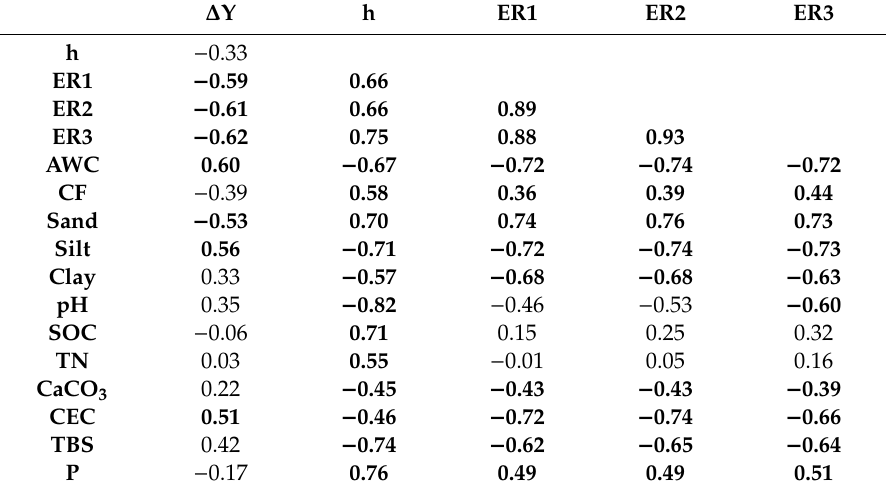
Table 3. Pearson’s correlation between the mean yield variation ( ∆ Y), elevation (h), electrical resistivity (ER1, ER2, ER3) measured by proximal sensing and soil features (CF: coarse fragments, AWC: available water capacity, TN: total nitrogen, SOC: soil organic carbon, CEC: cation exchange capacity, TBS: total base saturation, P: assimilable phosphorus). The AWC was calculated by a pedofunction which used clay, sand, CF, and bulk density as input data (Saxton and Rawls, 2006). In bold, values significant for p < 0.01.